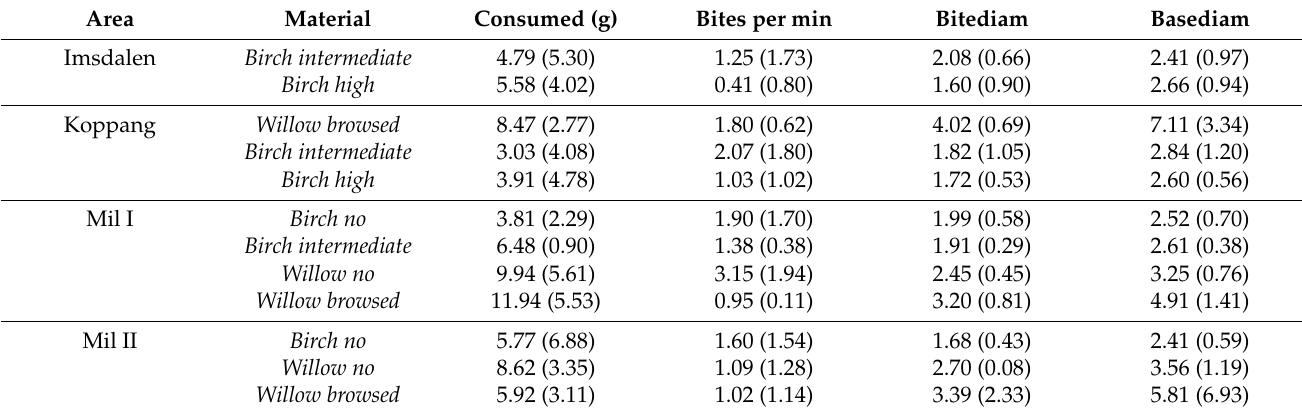
Table 1. Mean values ( ± 95 % CI) of biomass consumed, bites per minute, bitediameter (mm) and shoot basediameter (mm) for downy birch without (0%), intermediate (30% < 60%), and high levels of previous moose browsing (>90%), and goat willow without browsing (0%) and more than 30% previously browsed. Branches were collected in the four areas Imsdalen, Koppangskjølen Military area I and II.